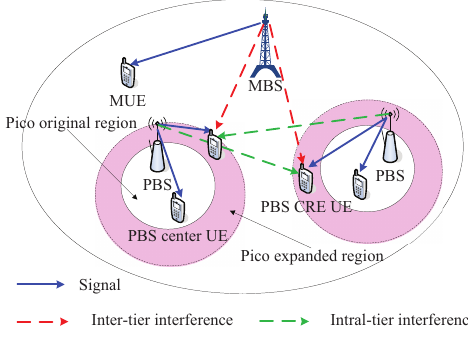
Figure 1. The network